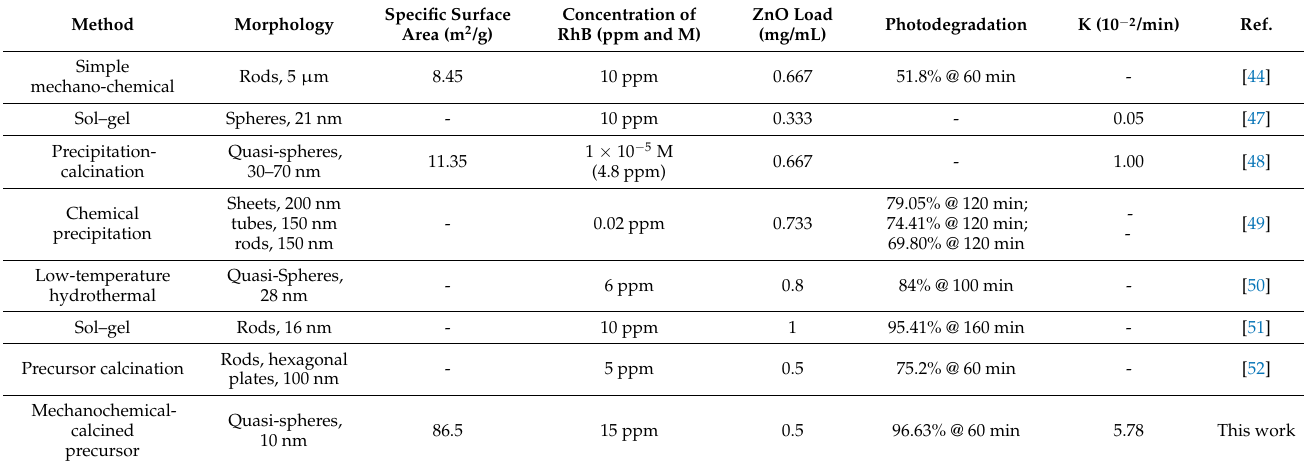
Table 3. Previous work on the degradation of RhB solutions by ZnO in simulated sources